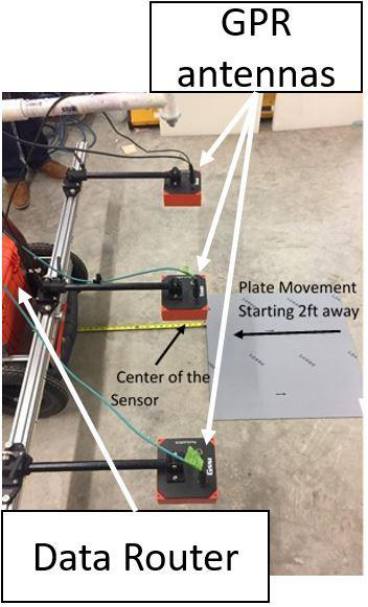
Figure 2. Picture of the DPS experiment showing presence of metal reflection at the first Fresnel zone.